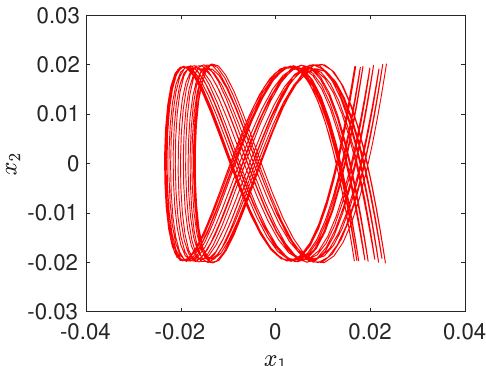
Figure 2. Phase portrait of the two-timing scale method